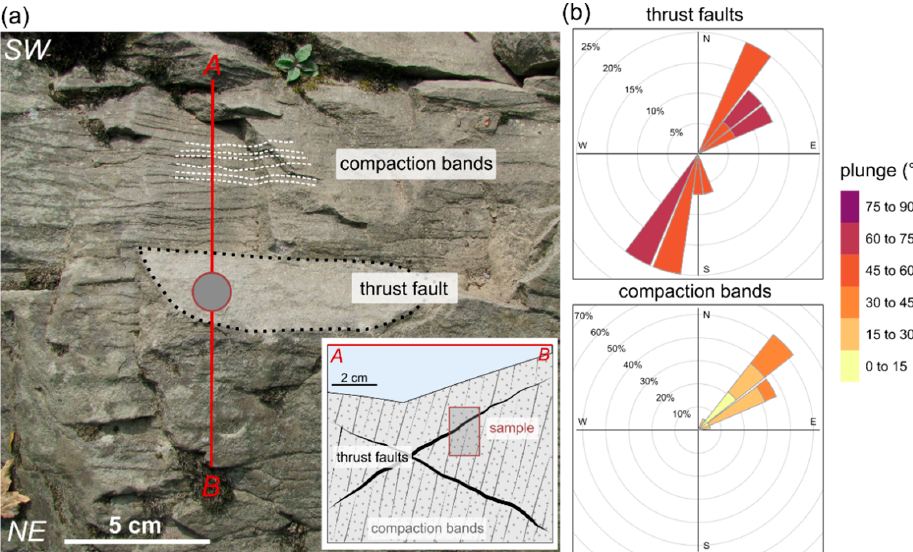
Figure 1. ( a ) A close view at the sandstones in the exposure and deformational microstructures within them. A situational cross-section of the sampling is presented in the bottom right corner; ( b ) The orientation of the micro-structures. Note that the orientation of normals to the micro-structures planes is presented.